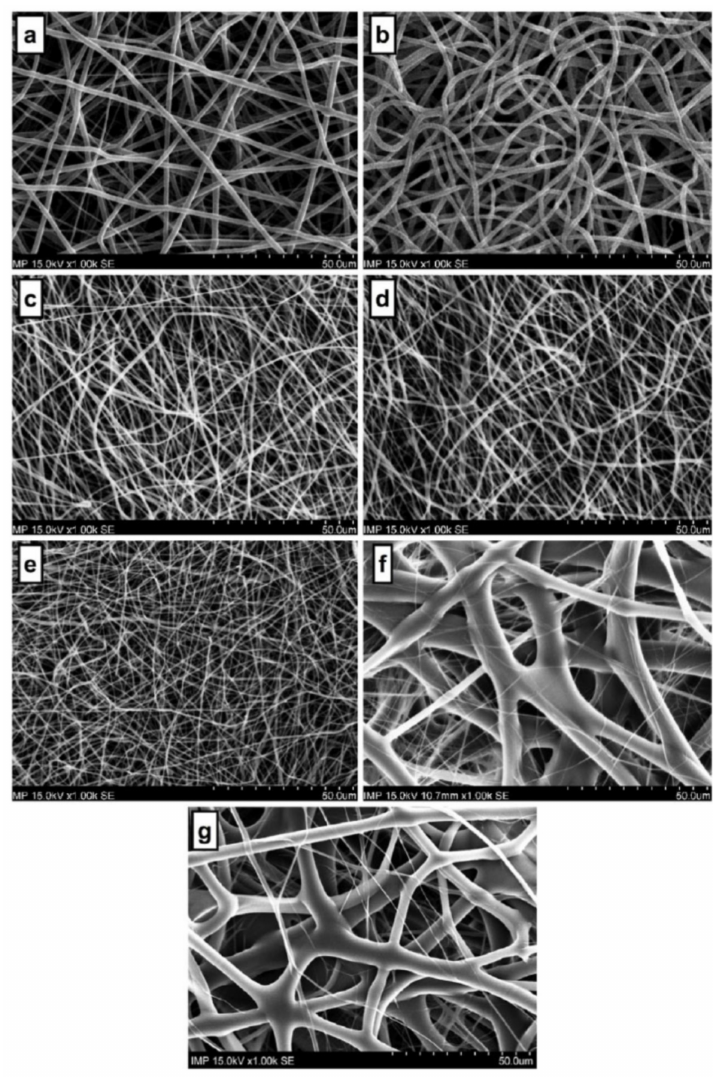
Figure 4. SEM images of PCL and PCL / gelatin electrospun mats spun in horizontal and vertical setup orientations. (Image from [69] reproduced with permission from SAGE Publishing). ( a ) 175 mg / mL PCL (horizontal). ( b ) 175 mg / mL PCL (vertical). ( c ) 150 mg / mL PCL—25 mg / mL gelatin (horizontal). ( d ) 150 mg / mL PCL—25 mg / mL gelatin (vertical). ( e ) 125 mg / mL PCL—50 mg / mL gelatin (horizontal). ( f ) 125 mg / mL PCL—50 mg / mL gelatin (vertical). ( g ) 100 mg / mL PCL—75 mg / mL gelatin